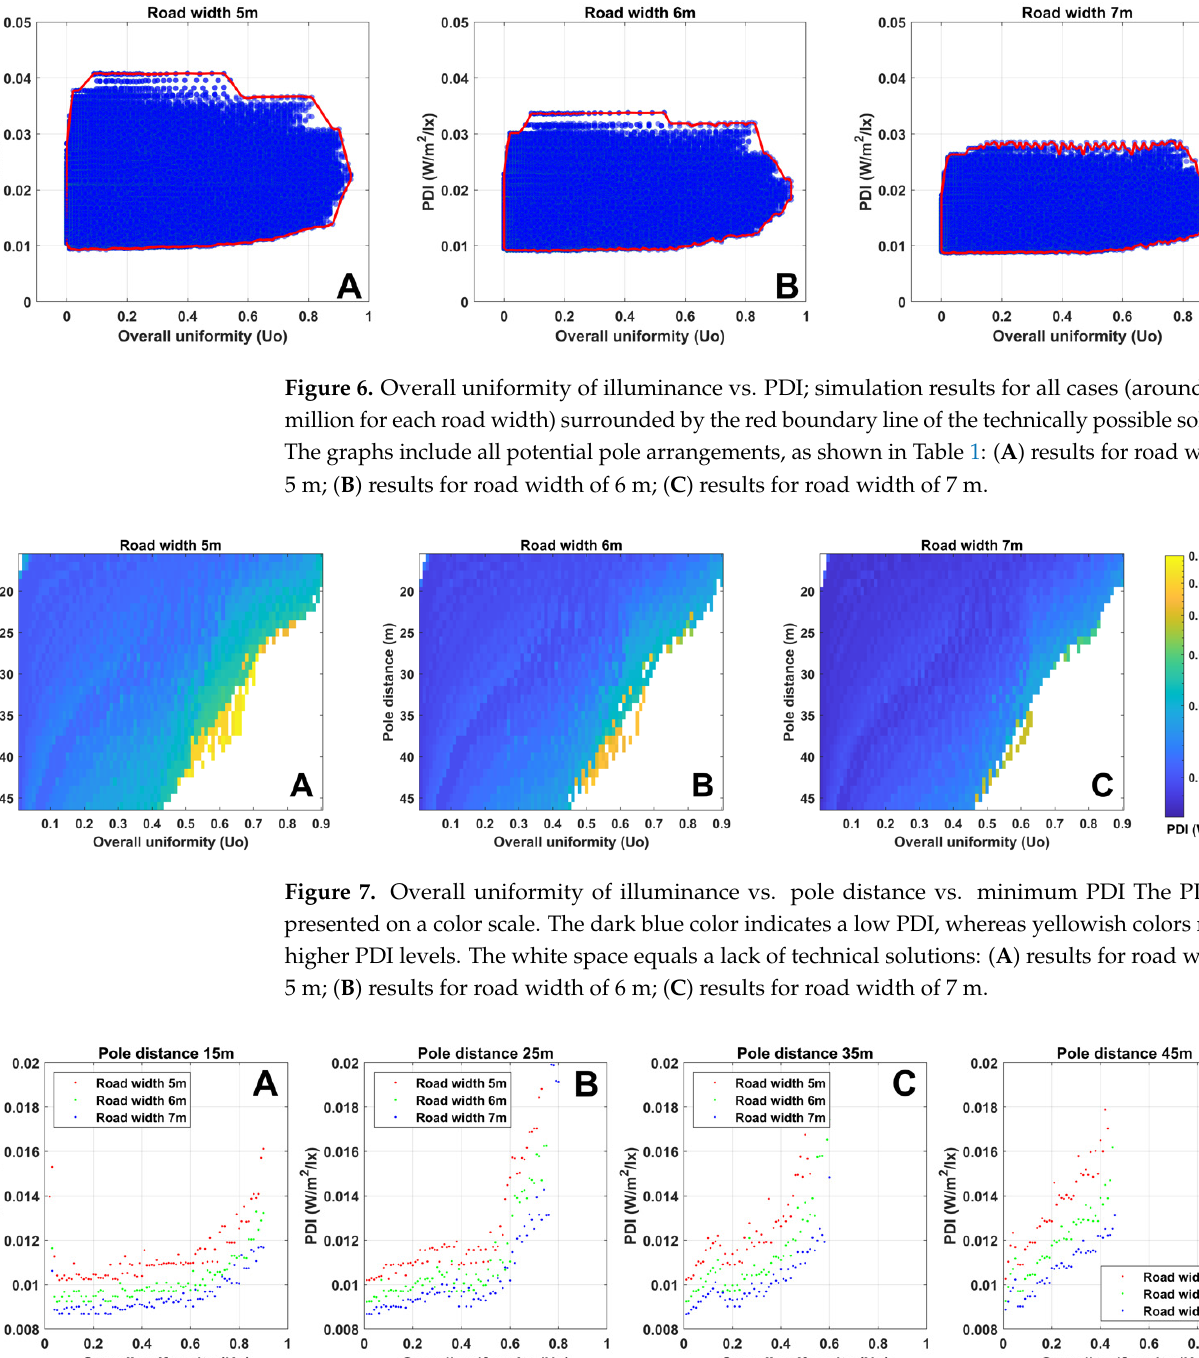
Figure 8. Overall uniformity of illuminance vs. minimum PDI for key pole distances: ( A ) results for pole distance of 15 m; ( B ) results for pole distance of 25 m; ( C ) results for pole distance of 35 m; ( D ) results for pole distance of 45 m.